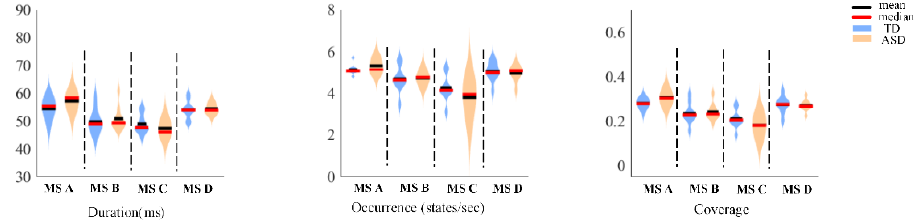
Figure 7. The differences in the three temporal parameters of the four microstates before tDCS and after tDCS for the control group.